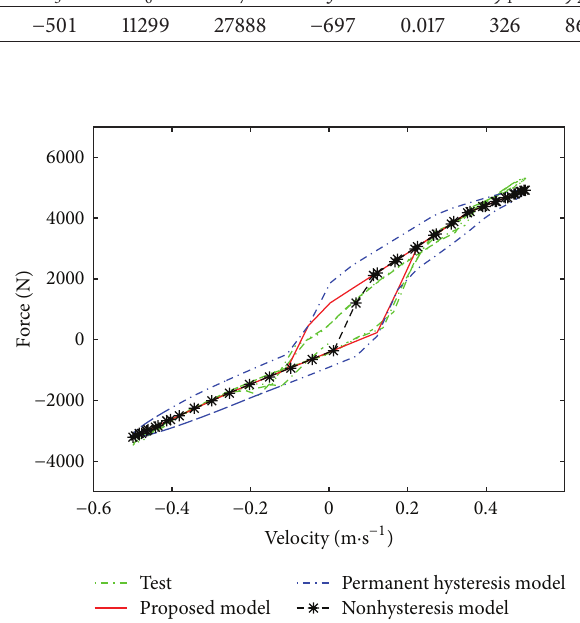
Figure 7: Different simulations and the corresponding testing